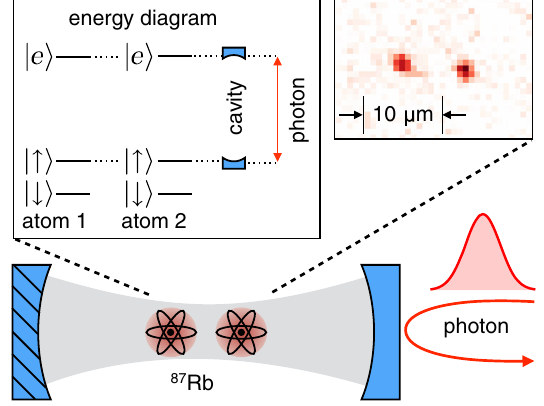
FIG. 1. Schematic representation of the setup. Two 87 Rb atoms are trapped at the center of a cavity with asymmetric mirror transmissions. Photons impinge on the mirror with higher trans- mission and are reflected. The inset on the upper left-hand side shows a simplified level scheme of the atoms with the two ground states j ↓ i , j ↑ i encoding the qubit and the excited state j e i . The cavity is tuned to the j ↑ i ↔ j e i transition. The inset on the upper right shows a fluorescence image of two trapped atoms in the